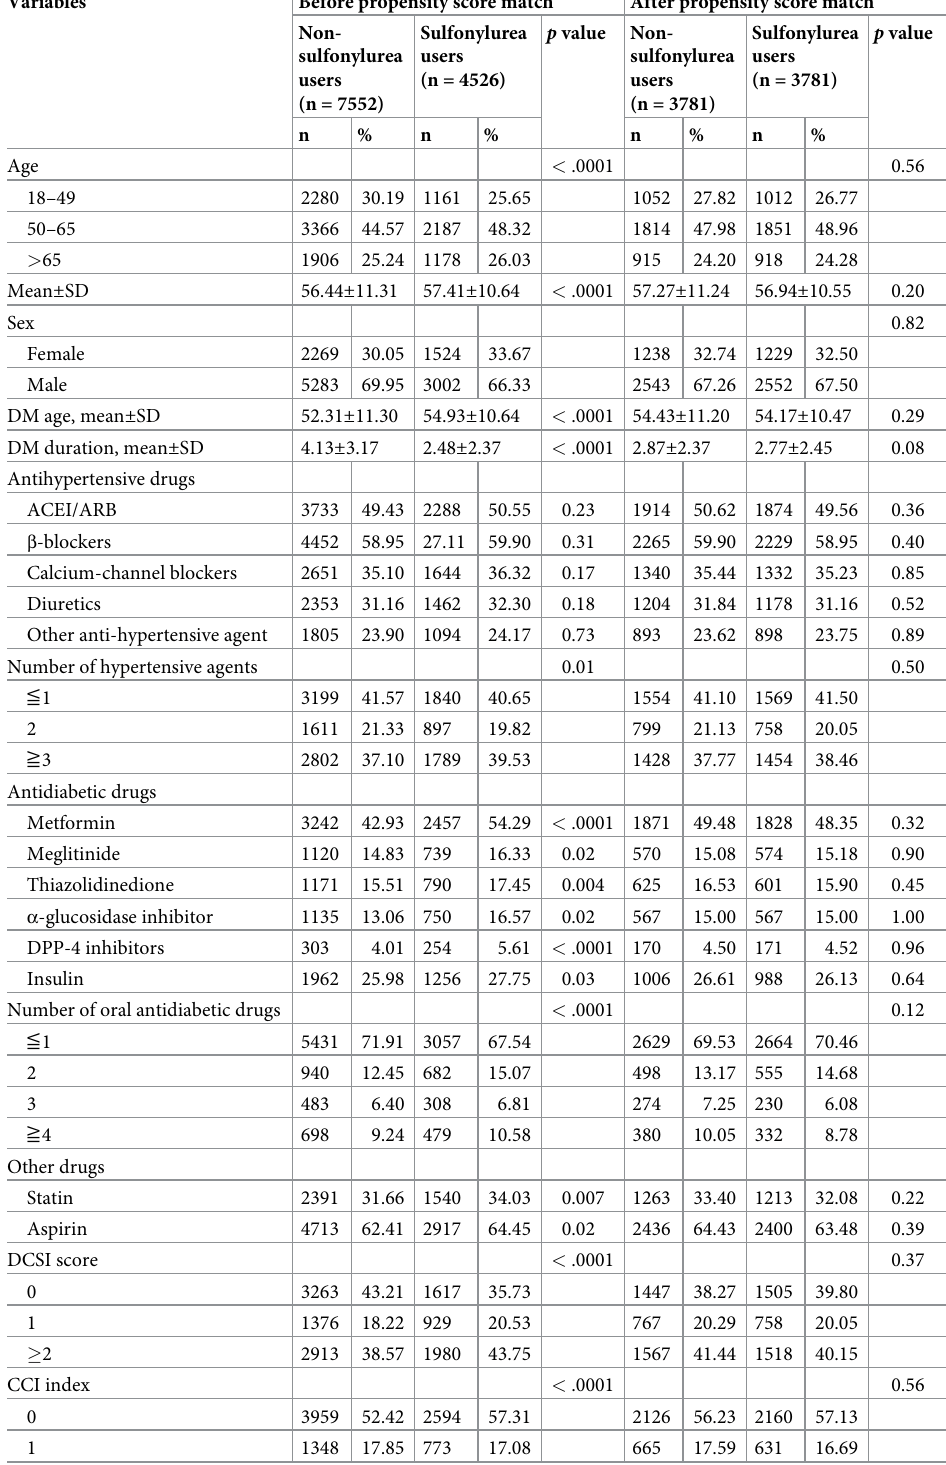
Table 1. Baseline characteristics of sulfonylurea users and nonusers in patients with type 2 diabetes mellitus and compensated liver